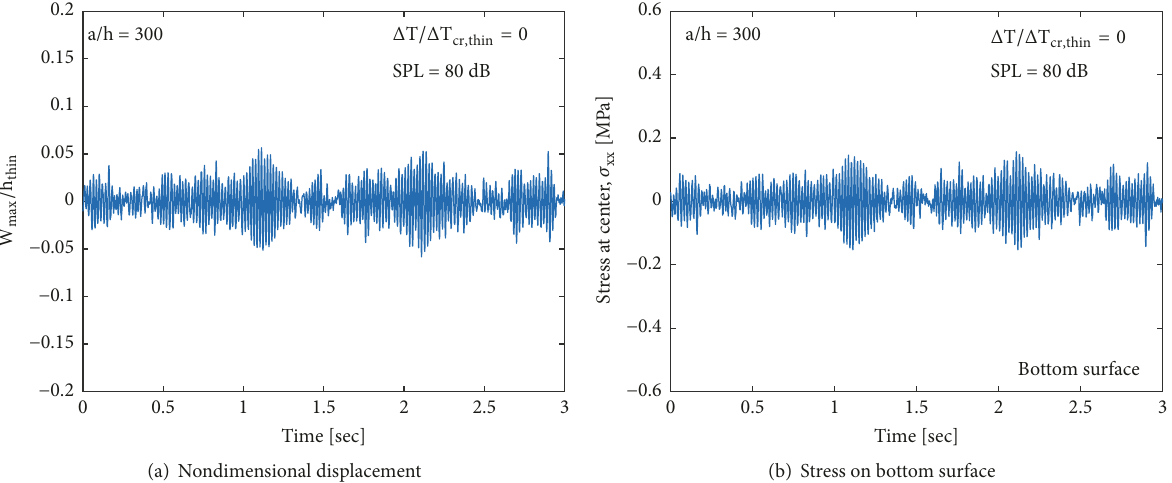
Figure 5: Small random vibrations about flat position (a/h = 300).